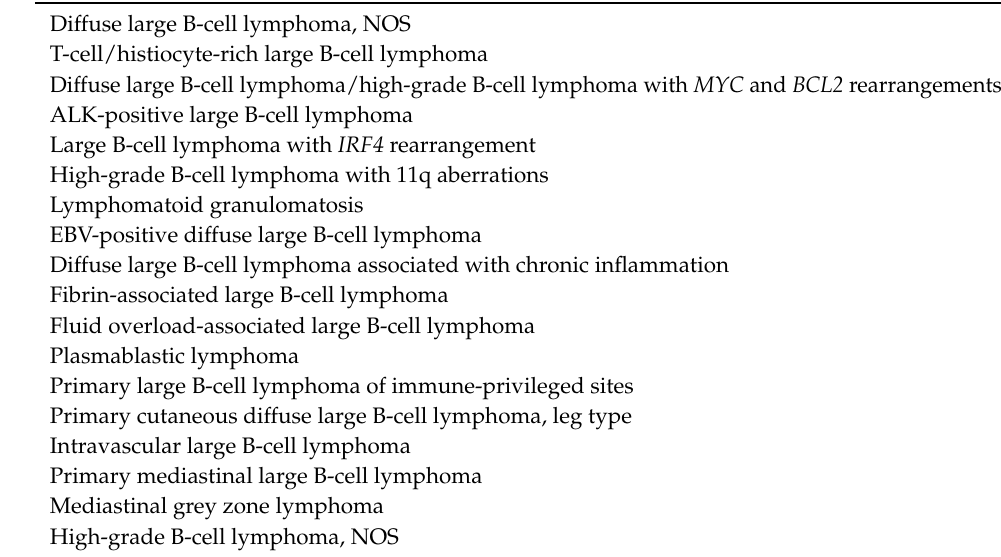
Figure 1. Diffuse large B-cell lymphoma, NOS (H&E ×400). There is a diffuse effacement of the architecture by medium-sized and large blastic cells that have a moderately basophilic cytoplasm and round nuclei with light chromatin and one to several nucleoli. Table 1. Large B-Cell Lymphomas in WHO-HAEM5.